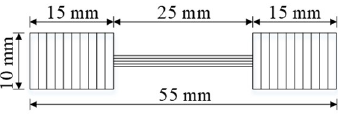
Figure 1. Schematic diagram of a fiber bundle specimen. Five PET fiber bundle specimens were tested for each displacement rate of 1, 2, 3, and 4 m / s with − 1 the respective strain rates of 40, 80, 120, and 160 s , which is the ratio of the displacement rate to the corresponding gauge length of the specimen, using an Instron drop-weight impact system (Figure